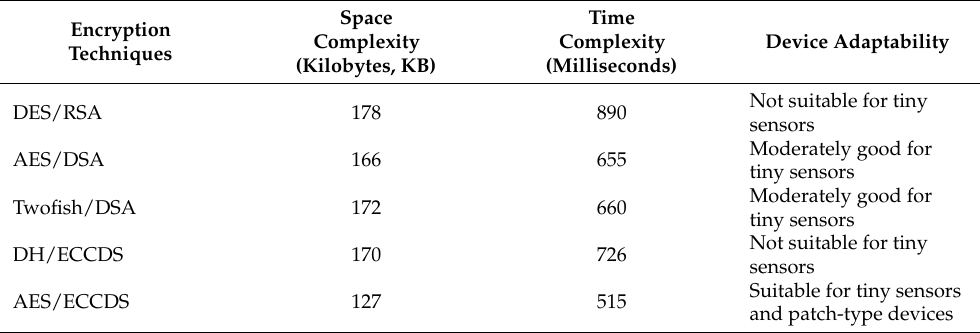
Table 2. Complexity Levels and Device Adaptability.